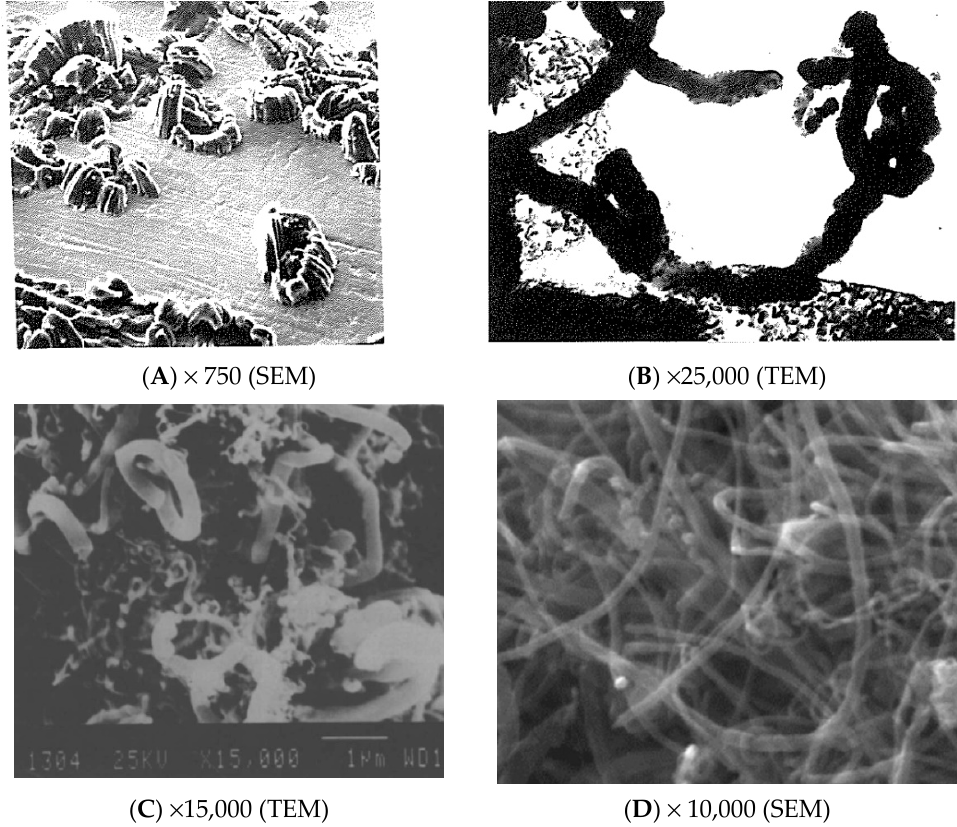
Figure 2. SEM/TEM Images of CNTs grown on Fe ( A , B ) [45], on steel ( C ) [9], and on AISI 316L ( D ) [36]. Reprinted from [9,36] (with permission of Elsevier) and from [45] (open PhD text).